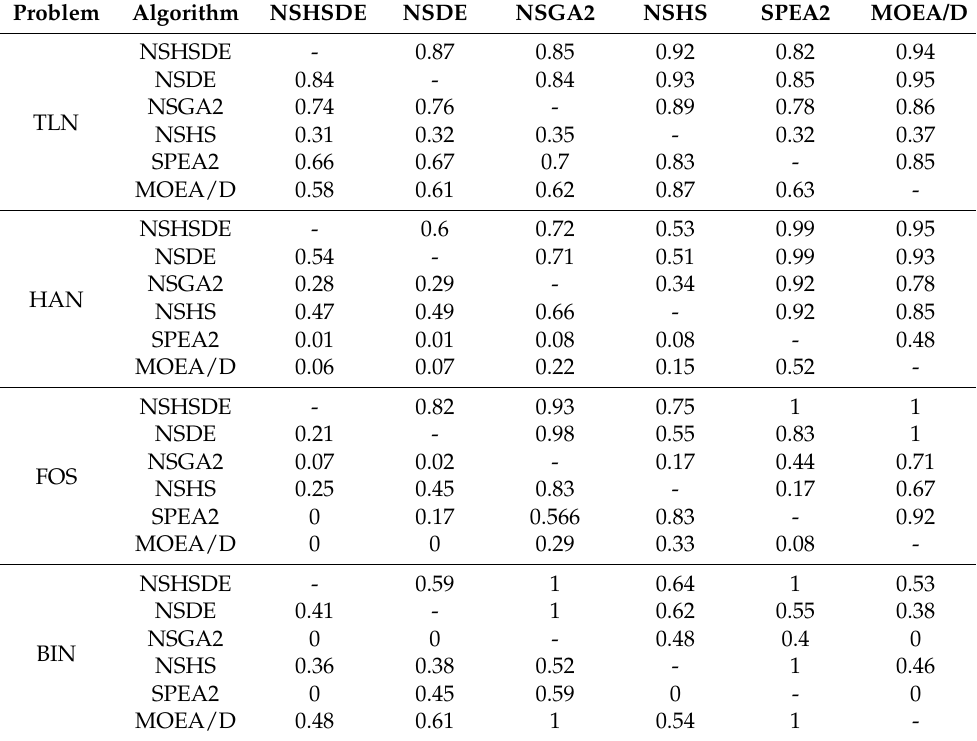
Figure 7. A close-up view of Pareto fronts (PFs) generated by Non-Dominated Sorting Harmony Search (NSHS) and nondominated sorting genetic algorithm 2 (NSGA2), ( a ) FOS problem; ( b ) BIN problem. Table 9. Comparison of multi-objective algorithms using the coverage set (CS)